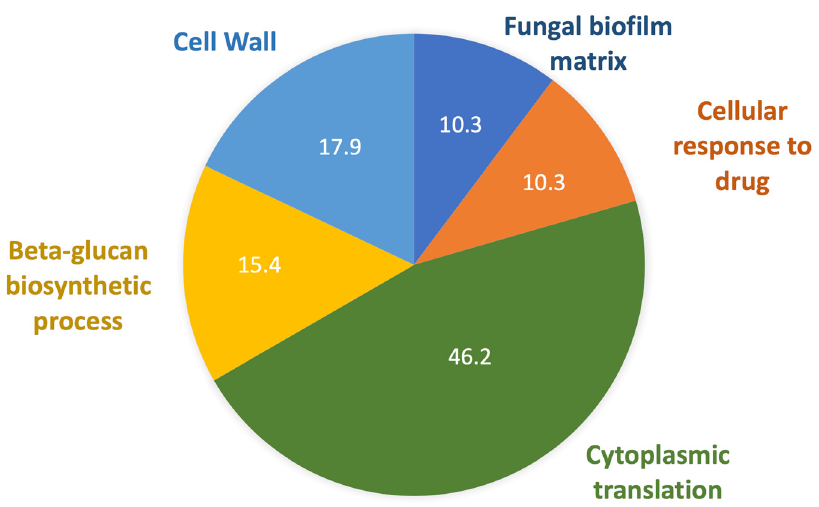
Figure 5. Proteins present in C. auris EVs. Pie chart of gene ontology terms identified in the EVs from all the strains enriched when the cells were treated with caspofungin.